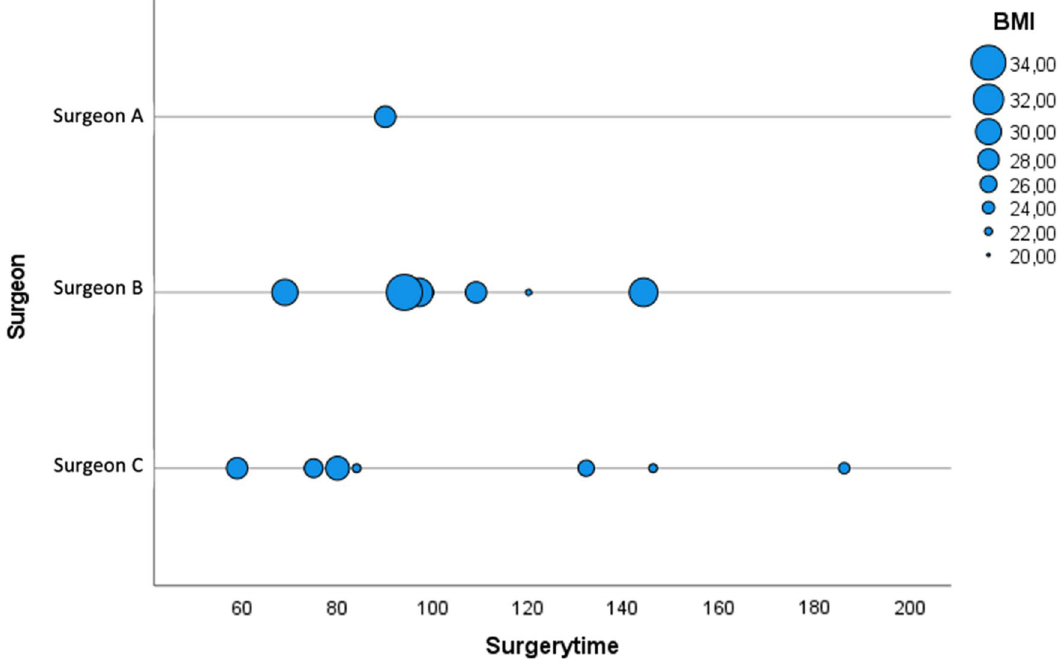
Figure 4. Surgery times (minutes) based on BMI and